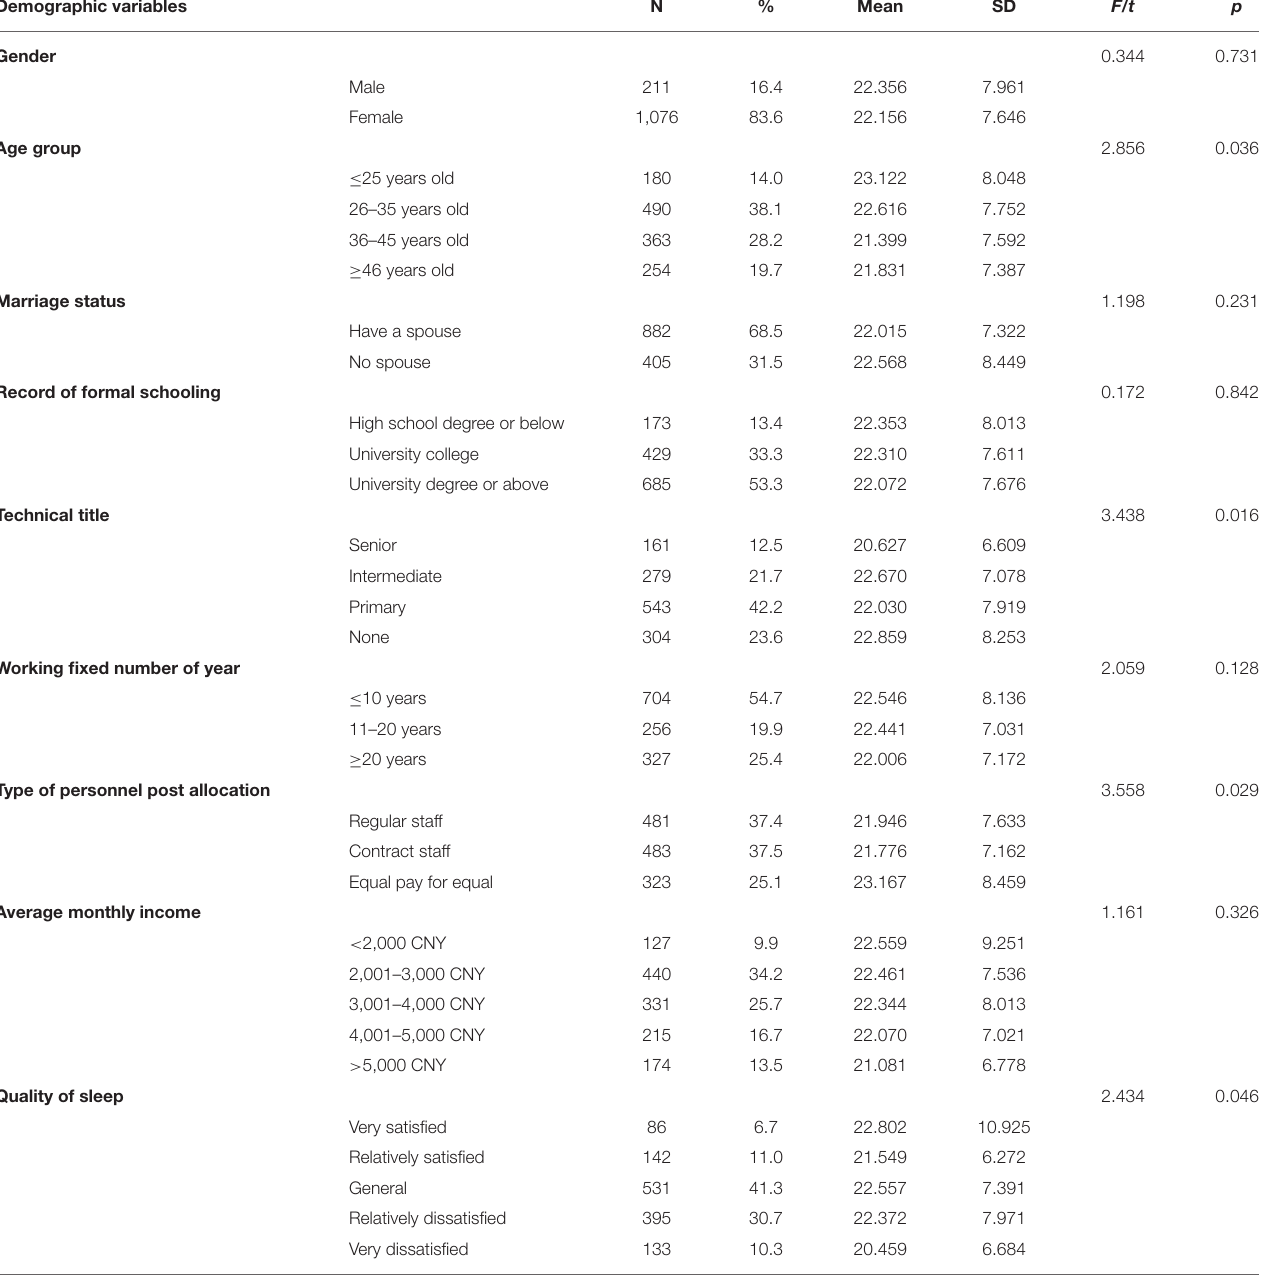
TABLE 2 | Average job performance of respondents.